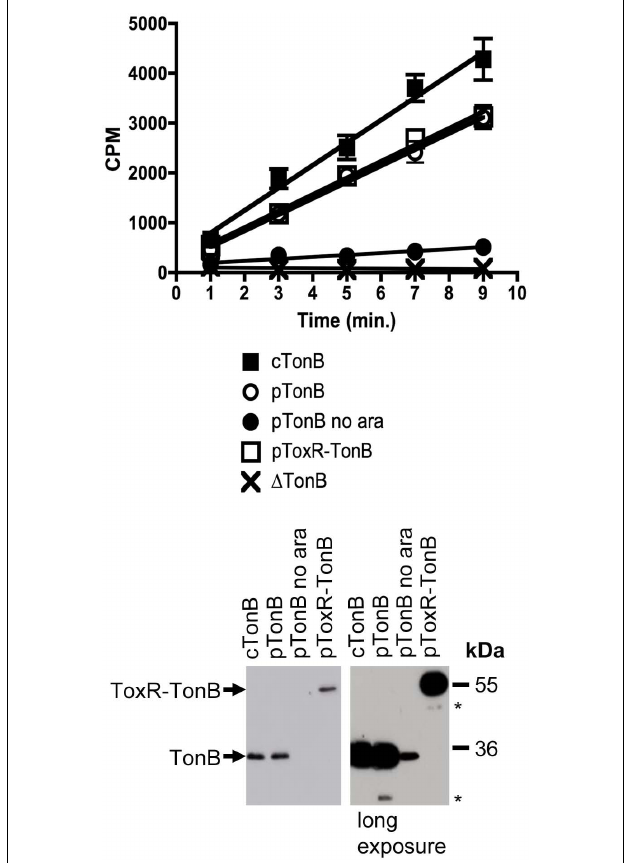
FIGURE 4 |ToxR–TonB supports as much activity as plasmid-encoded wild-typeTonB. Ferrichrome transport assays were performed as described in Section “Materials and Methods” with the following strains: cTonB (W3110 expressing chromosomally encodedTonB); Δ TonB (KP1344); pTonB (KP1344/pKP325); pTonB no ara (KP1344/pKP325 uninduced); and pToxR–TonB (KP1344/pKP1529). L-Arabinose was added to induce expression of plasmid-encodedTonB as follows: 0.00075% for pTonB and 0.00045% for pToxR–TonB. Initial ferrichrome transport rates are as follows, expressed as counts per minute (cpm)/0.05 A 550 mlcells/minute: cTonB 453 ± 31; pTonB 326 ± 13 (standard to 100%); pTonB no ara 39 ± 7